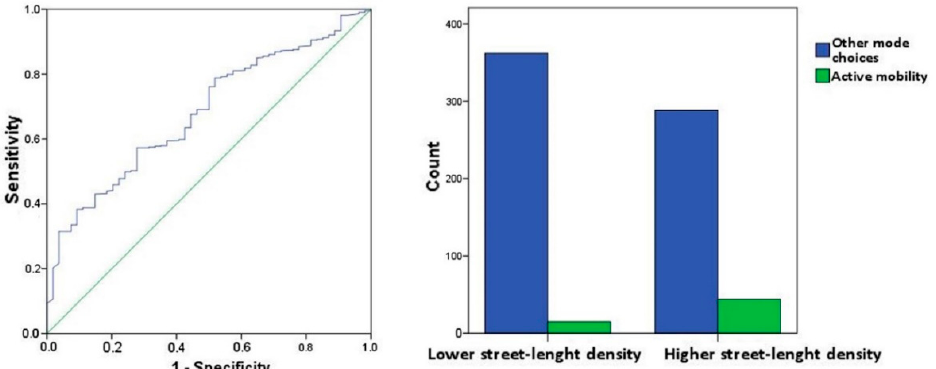
Figure 4. Curve analysis for street-length density and the use of active mobility modes for commuting around homes.